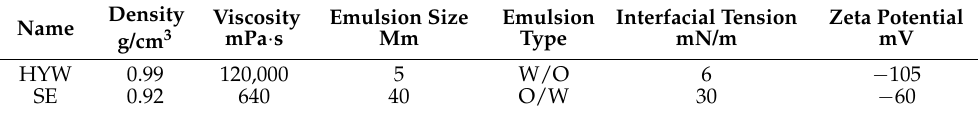
Table 3. HYW and SE emulsion characteristics.